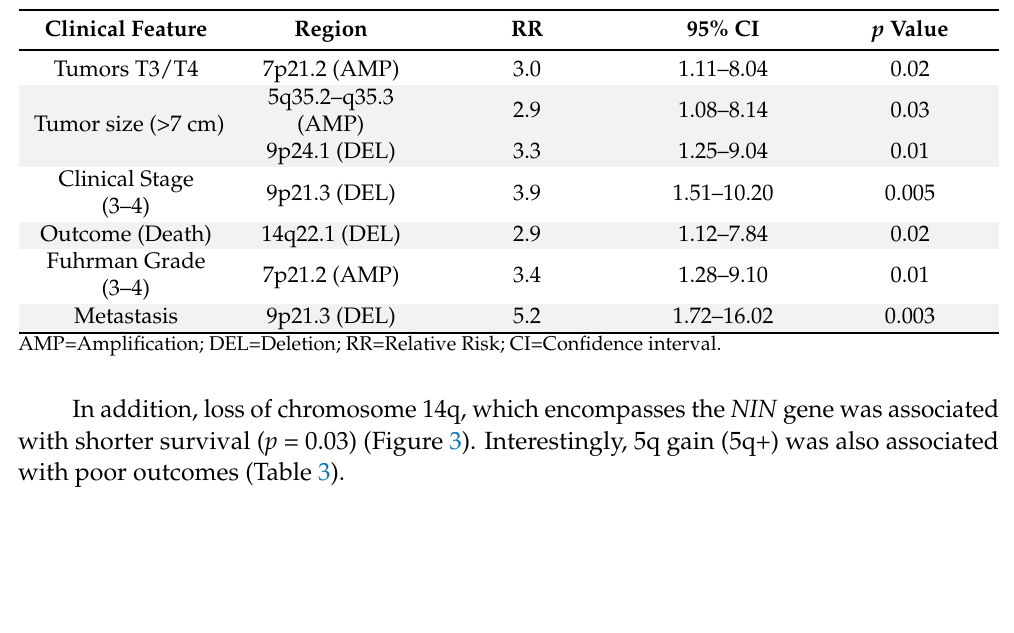
Table 4. Multivariate analysis of clinical features associated with STAC significant